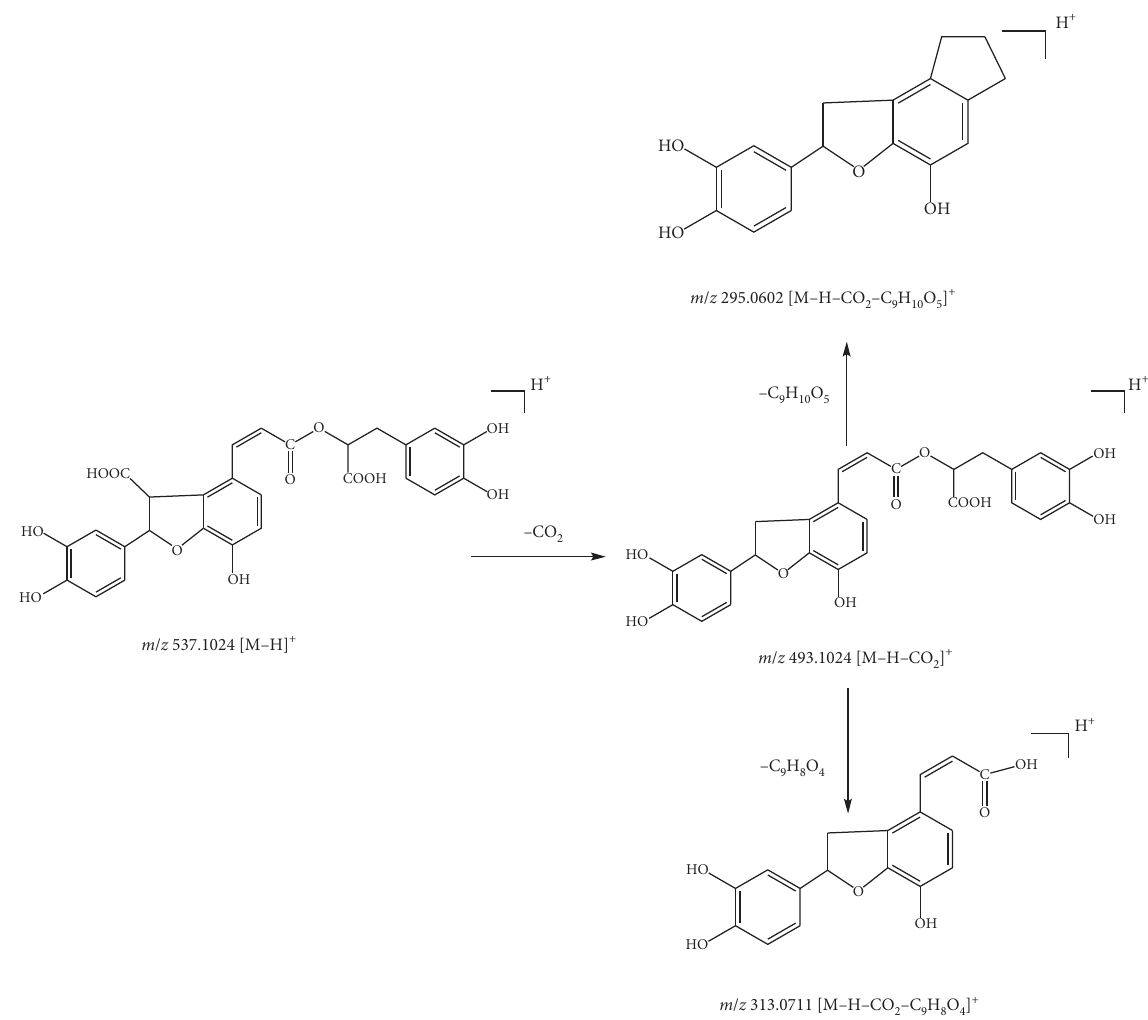
Figure 6: Possible fragmentation pathway of compound